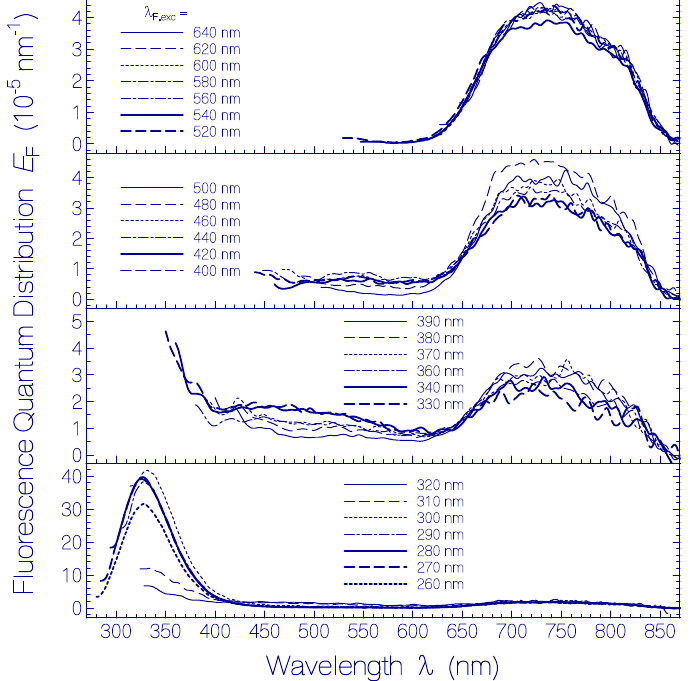
Figure 2. Fluorescence emission quantum distributions E F ( λ ) of fresh thawed QuasAr1 in pH 8 Tris buffer. The fluorescence excitation wavelengths λ F,exc are indicated in the sub-figures.